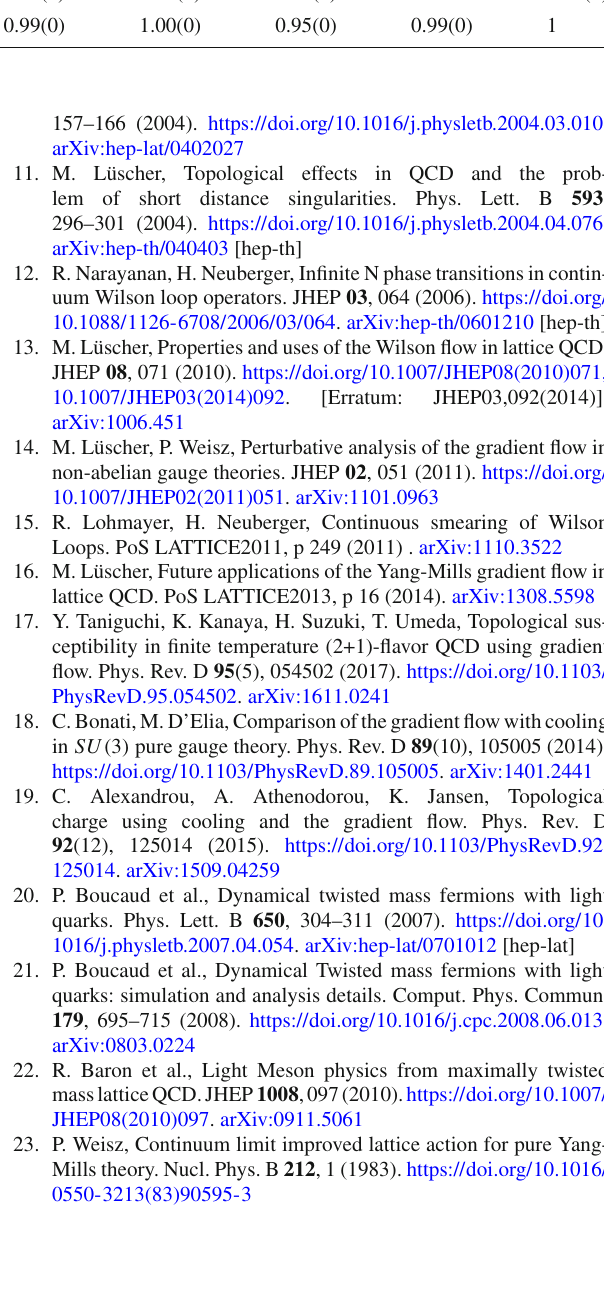
relation coefficient between different definitions and its error (0 means that the error is smaller than